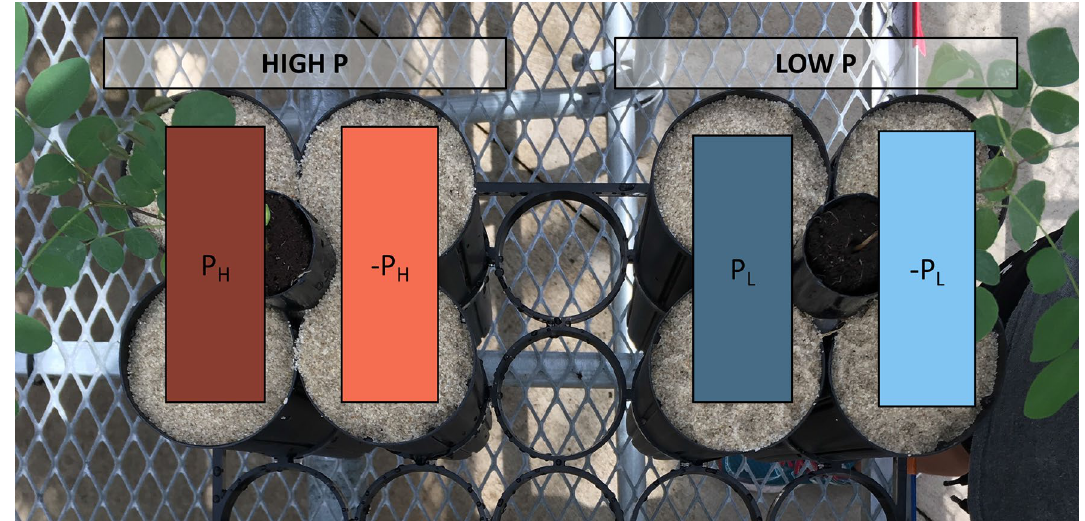
determined by whether the seedling was in a high or low P treat- ment group. The other two root sections of a seedling received fer- tilizer with no P (-P and -P H L